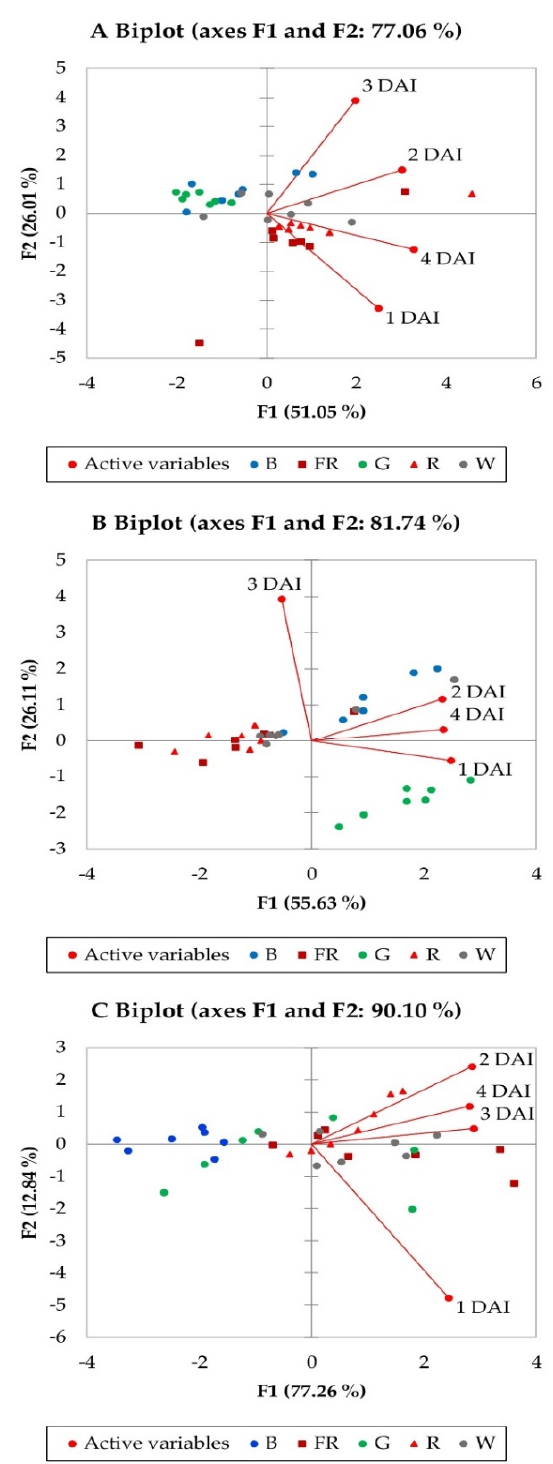
Figure 2. A principal component analysis biplot, indicating distinct effects of lighting treatments on C. acutatum mycelium growth rate under various photosynthetic photon flux densities and LED light wavelength. ( A )—50 µ mol m − 2 s − 1 , ( B )—200 µ mol m − 2 s − 1 , ( C )—200 µ mol m − 2 s − 1 . B—blue (peak = 450 nm); G—green (peak = 530 nm); R—red (peak = 660 nm); FR—far red (peak = 735 nm); W—white (5700 K). DAI—days after